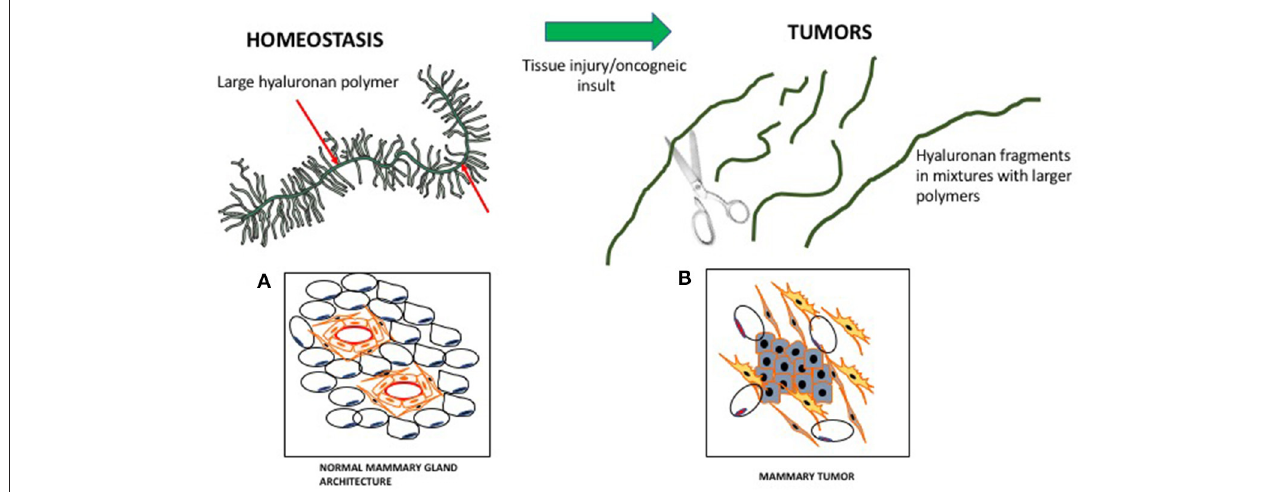
FIGURE 3 | Hyaluronan is a large polymer during tissue homeostasis and fragmented in wounds and tumors . In homeostasis, large hyaluronan polymers are decorated by proteins/proteoglycans, which contribute to normal tissue architecture. (A) Cartoon of a virgin mouse mammary gland. (B) Cartoon of a mouse mammary tumor (Blue, mammary tumor cells). During wounding, fragmented hyaluronan polymers produced by ROS/hyaluronidases activate fibroblasts and attract immune cells, which contribute to the loss of tissue